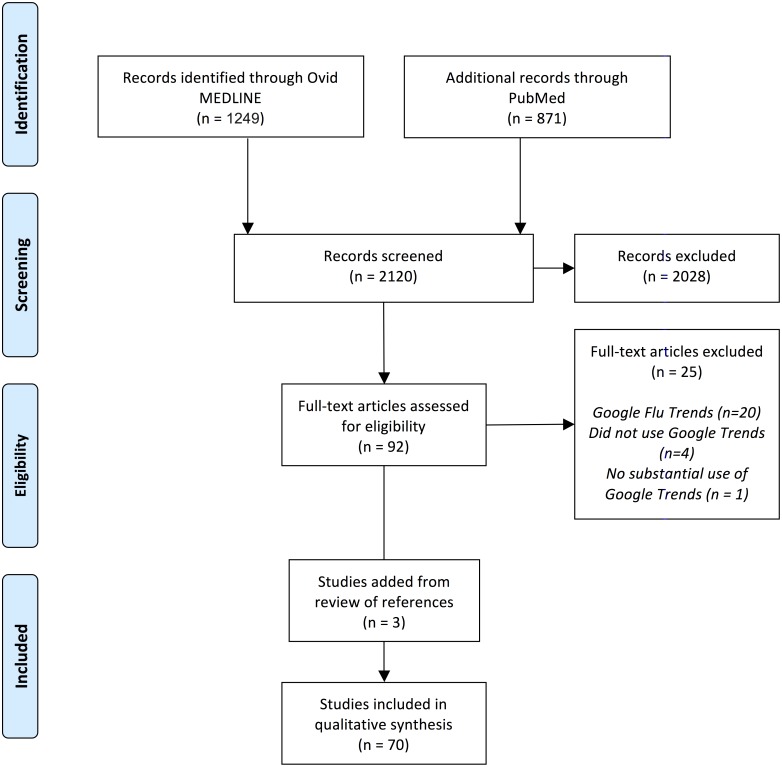
PRISMA Flow Diagram.